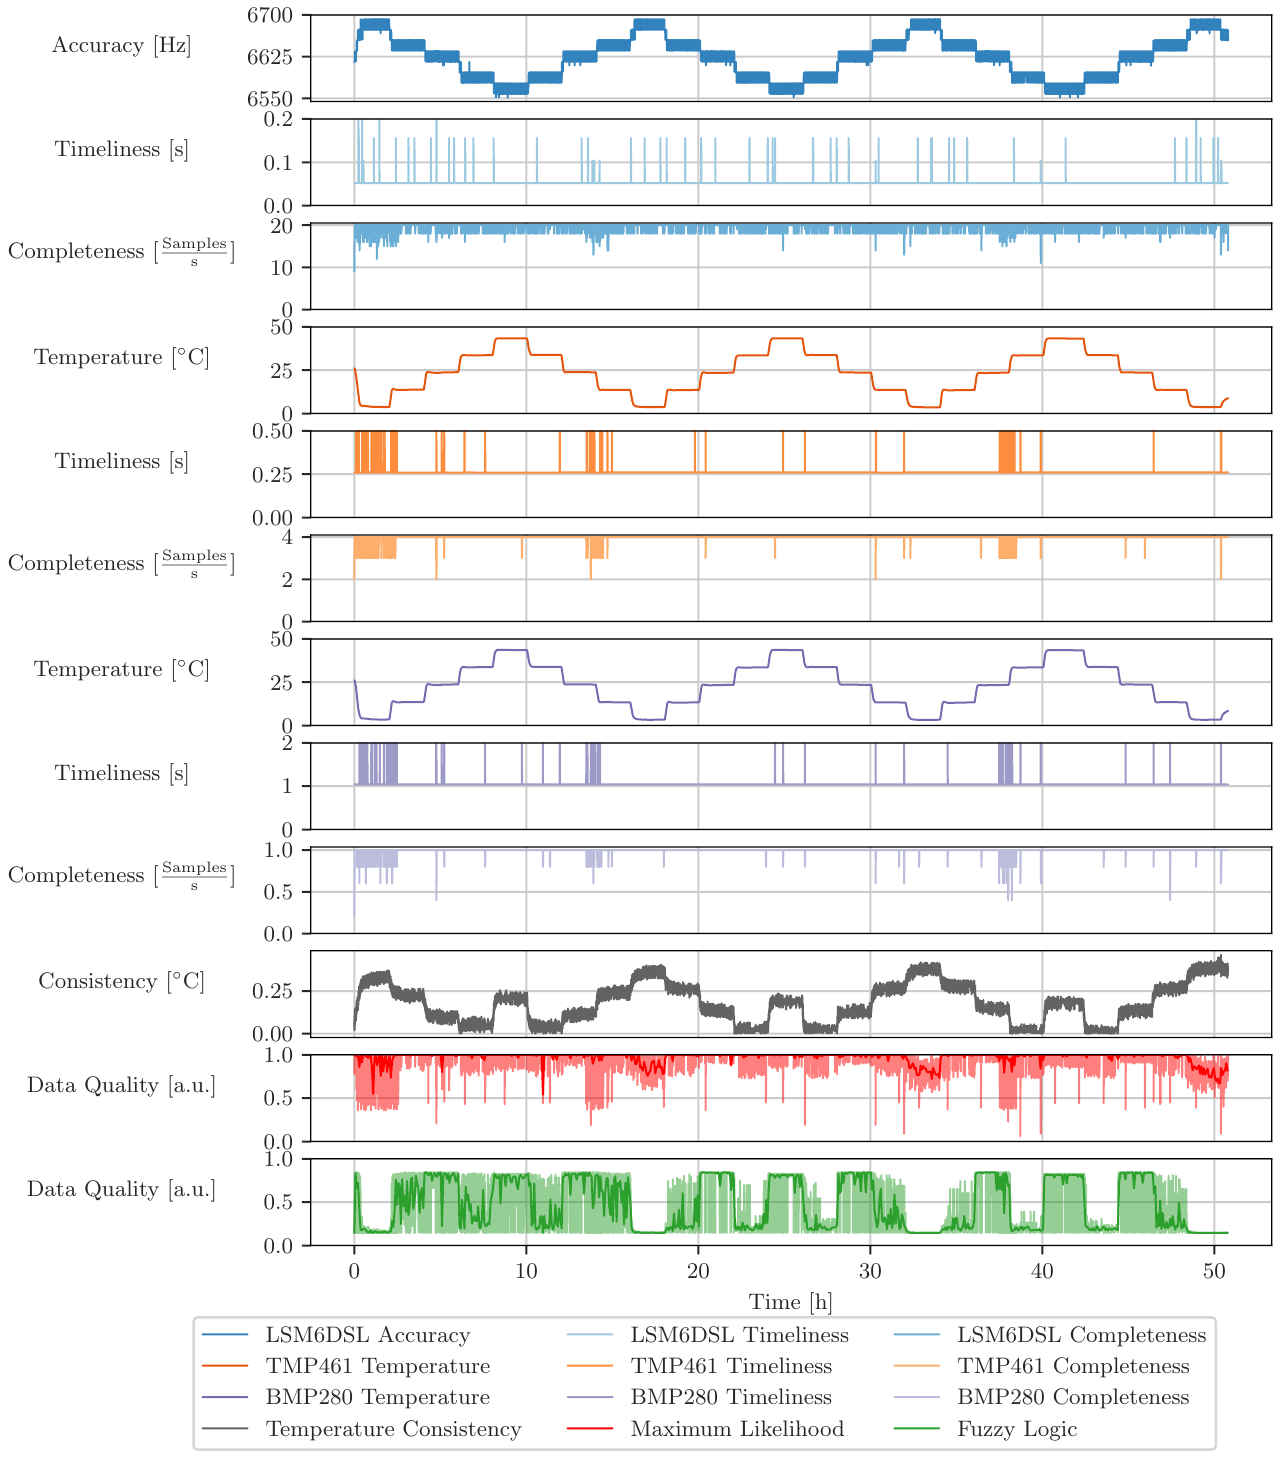
Figure A2. Accelerometer Data Set, sensor system 2, data quality attributes, measured values, and data quality